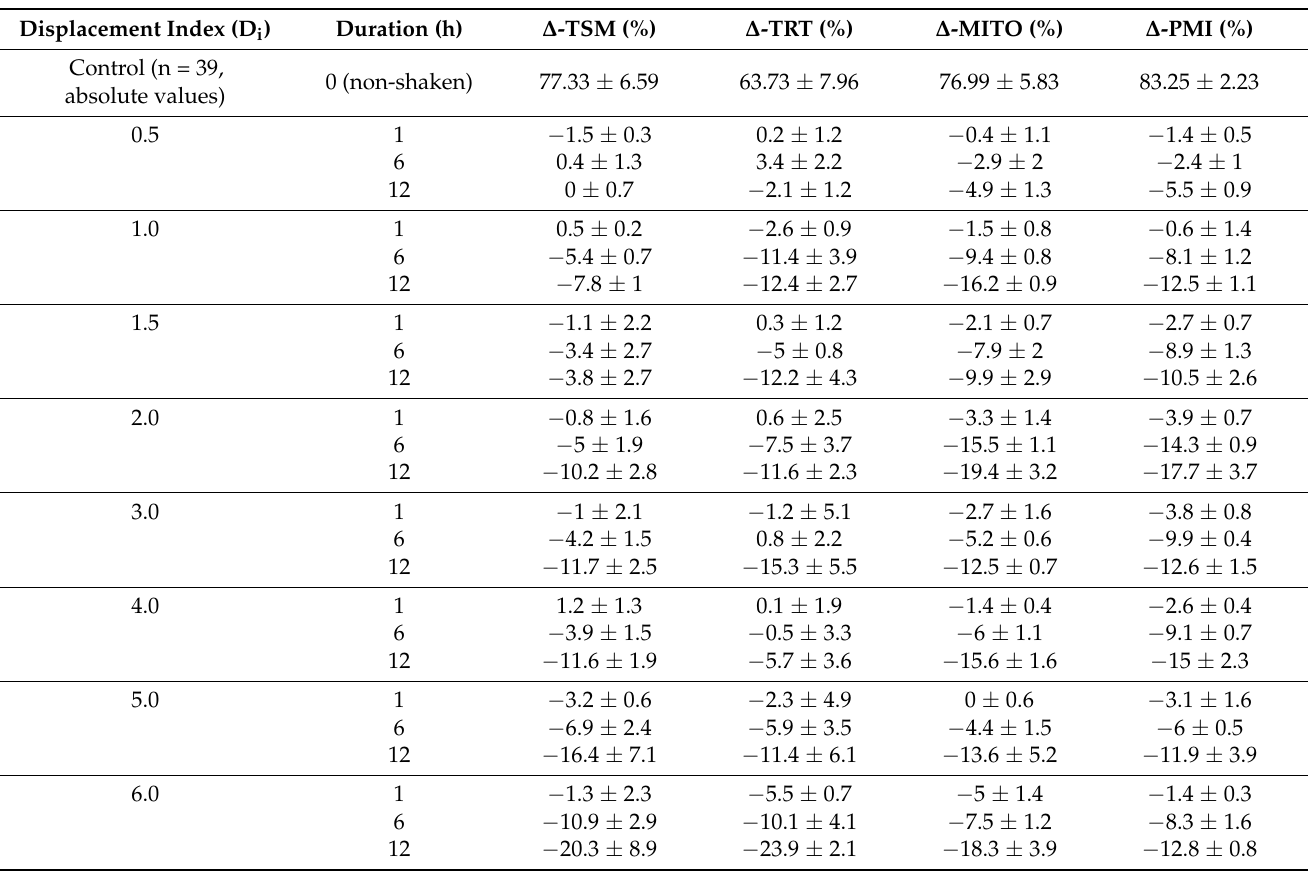
Table 2. Summarized impact of different vibration intensities (D i ± 0.1) on different sperm quality characteristics on d4 of semen storage, representing short (1 h), middle (6 h) and long (12 h) transport